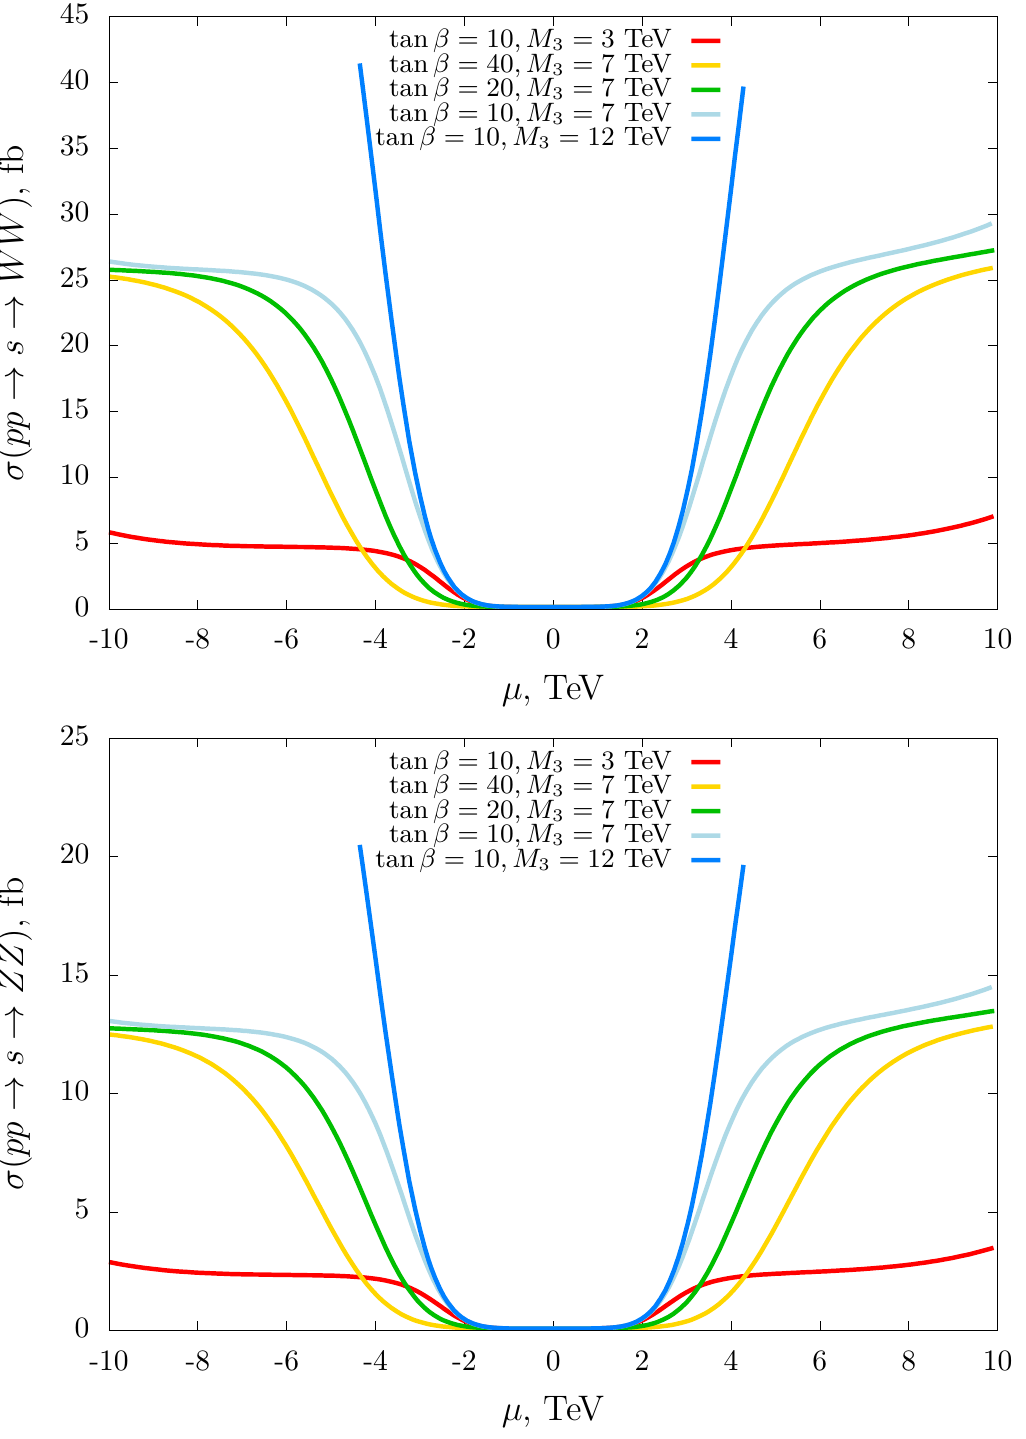
Figure 8. Resonant production cross section of the processes pp pp s ZZ (lower panel) calculated for p S = 14 TeV. The model parameters are chosen as ! ! m s = 1 TeV, m A = 5 TeV, M 1 = M 2 = 1 TeV, p F = 20 TeV, K p = 2, K d = 1 : 6.